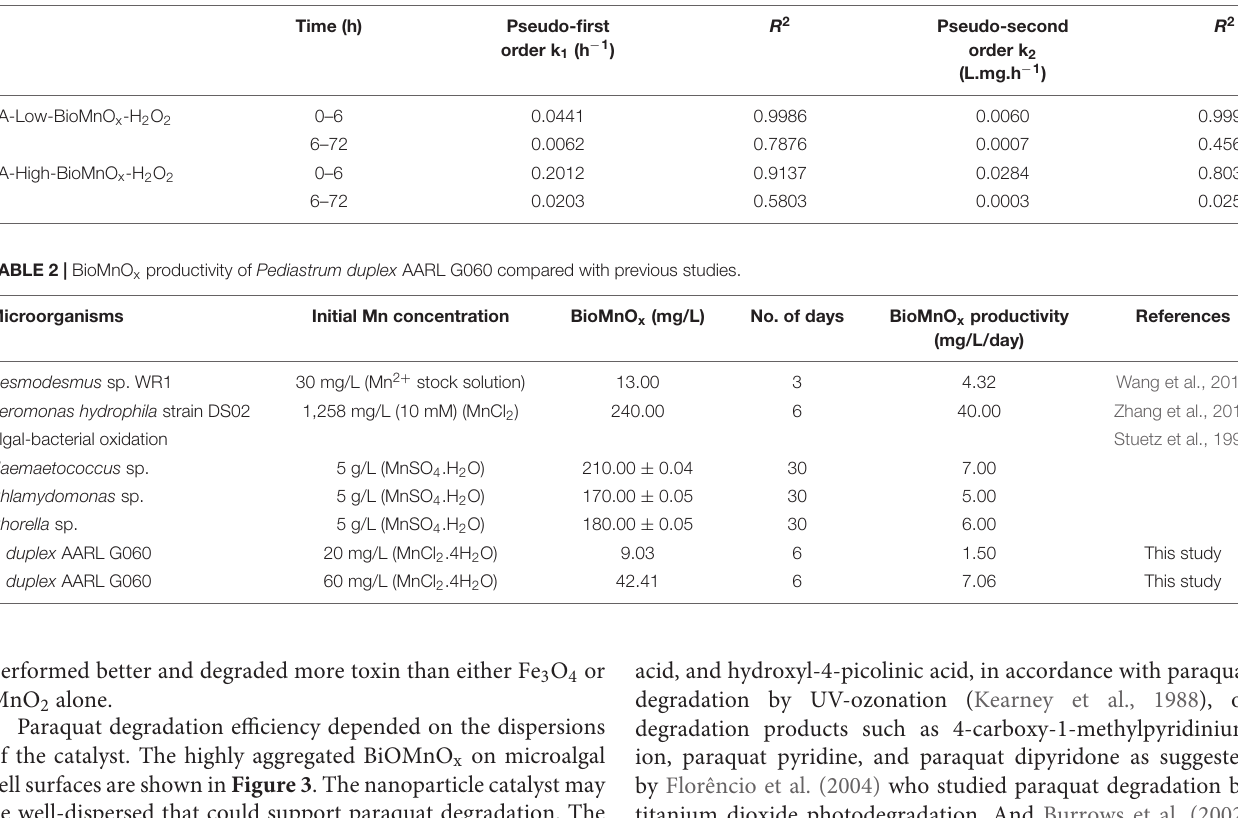
TABLE 1 | Kinetic parameters for Fenton-like oxidation of paraquat.